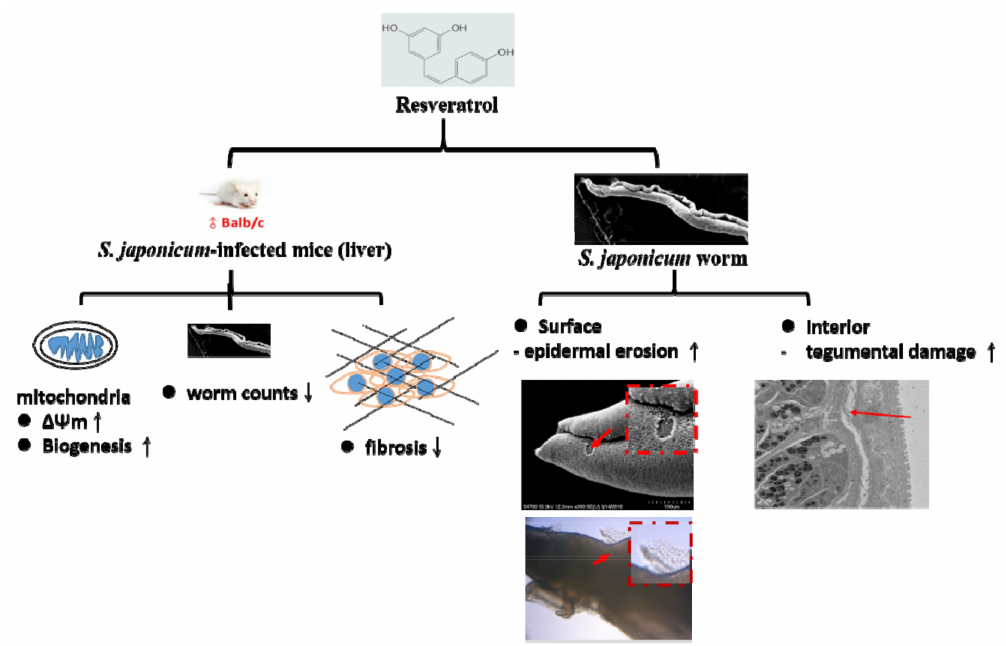
Figure 8. Schematic representation of the e ff ects of RSV treatment on S. japonicum -infected mice. As shown in the schematic, in the liver of S. japonicum –infected mice, RSV results in an increase in ∆ ϕ m and the protein expression of PGC-1 α (which is associated with mitochondrial biogenesis), thus improving mitochondrial function. RSV treatment also results in a decrease in the extent of liver fibrosis, as indicated by a decrease in the protein expression of the fibrosis markers collagen I, collagen III and α SMA. As a final e ff ect, RSV causes a decrease in the worm count in the liver and also causes damage to both the surface and interior tissues of the S. japonicum worms in S. japonicum -infected